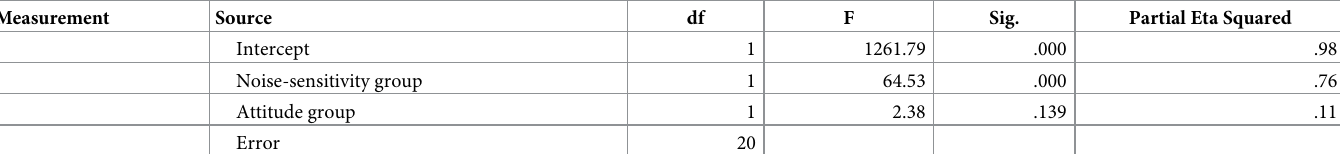
PLOS ONE | https://doi.org/10.1371/journal.pone.0202058 August 13,